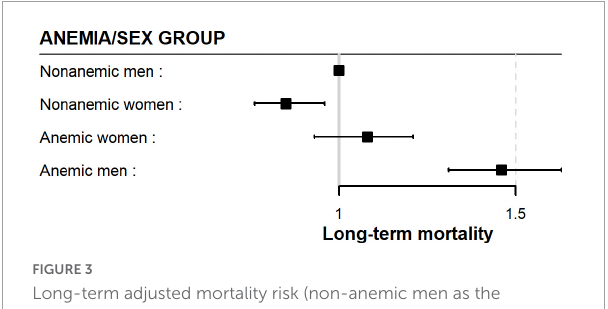
FIGURE3 Long-term adjusted mortality risk (non-anemic men as the reference